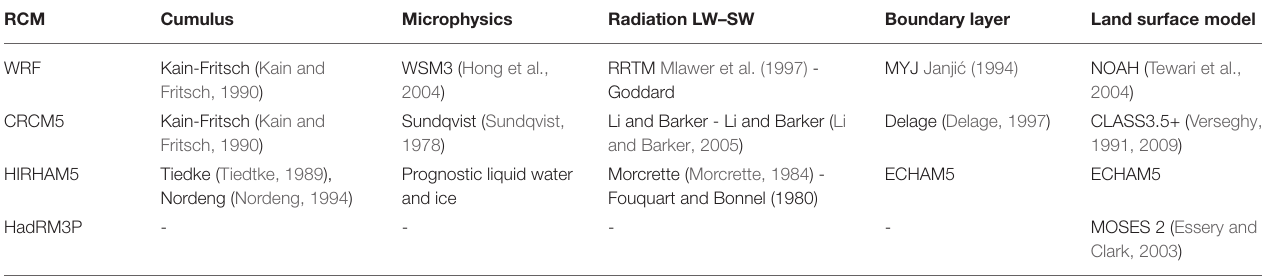
TABLE 2 | Major characteristics of the NA-CORDEX RCMs.